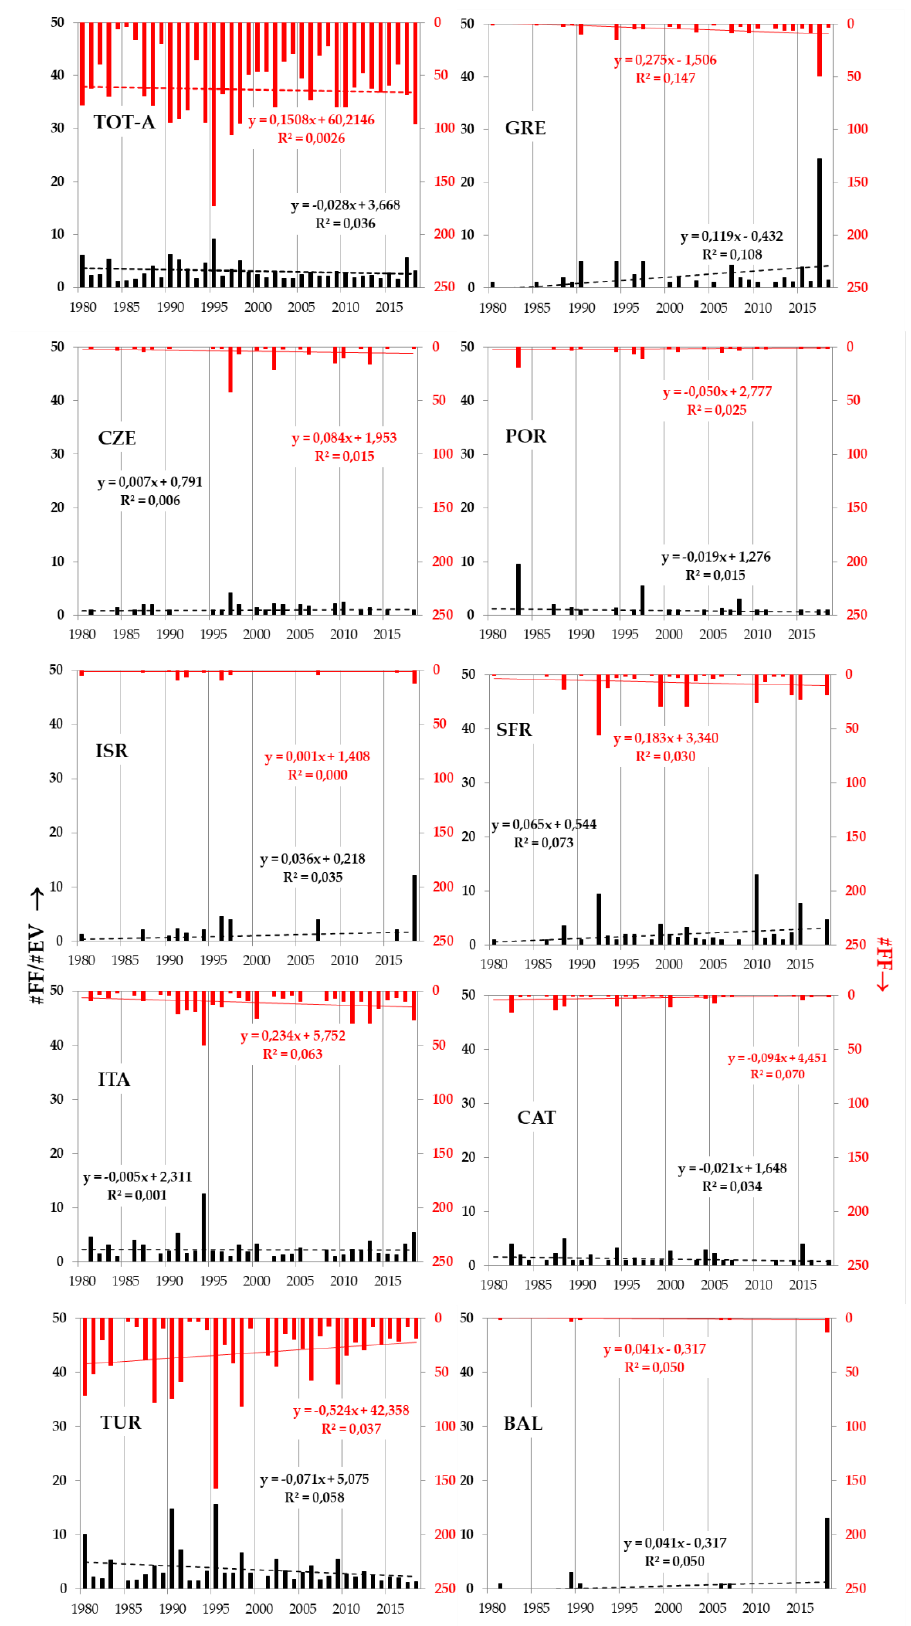
Figure 3. Annual variability in the number of fatalities (#FF, in red) and in the number of fatalities per event (#FF/#EV, in black), complemented by their linear trends.